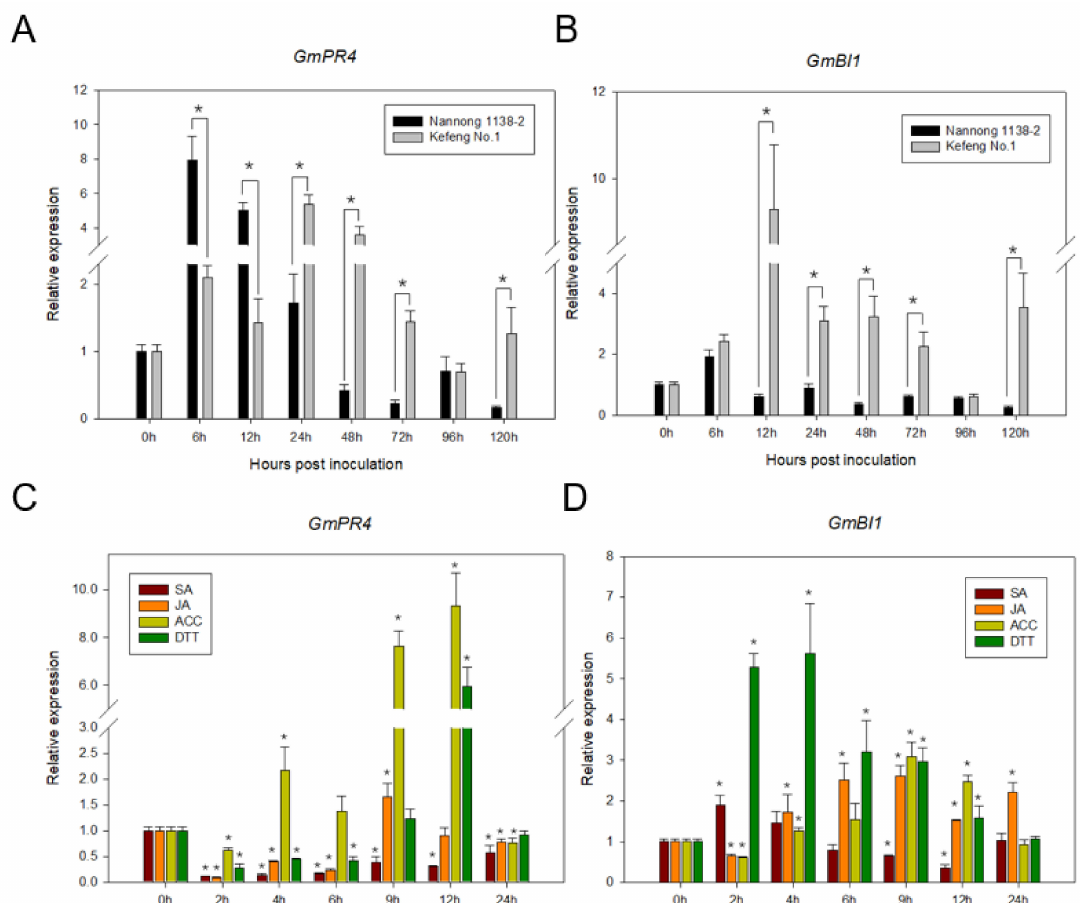
Figure 6. Expression analyses of GmPR4 and GmBI1 by qRT-PCR. The relative expression of GmPR4 ( A ) and GmBI1 ( B ) in Nannong 1138-2 (SMV-susceptible) and Kefeng No.1 (SMV-resistant) after SMV infection at 0, 6, 12, 24, 48, 72, 96, and 120 hpi. Y-axes indicate the ratios of relative expression levels between samples infected with SMV and samples inoculated with PBS (phosphate buffer saline), and X-axes indicate the hours post inoculation. The significant differences between susceptible and resistant plants were tested by one-way ANOVA, * p < 0.05. The relative expression of GmPR4 ( C ) and GmBI1 ( D ) after various stress treatments (SA, JA, ACC, and DTT) at 0, 2, 4, 6, 9, 12, and 24 hpt. Y-axes indicate the ratios of relative expression levels between samples under various stress treatments (SA, JA, ACC and DTT) and control treatment, X-axes indicate the hours post treatment. Each experiment was repeated three times. Error bars indicate standard deviation (SD). The significant differences were tested by one-way ANOVA and asterisks denote significance relative to 0 h for each treatment, p < 0.05. The soybean gene Tubulin was used as the internal control to normalize the